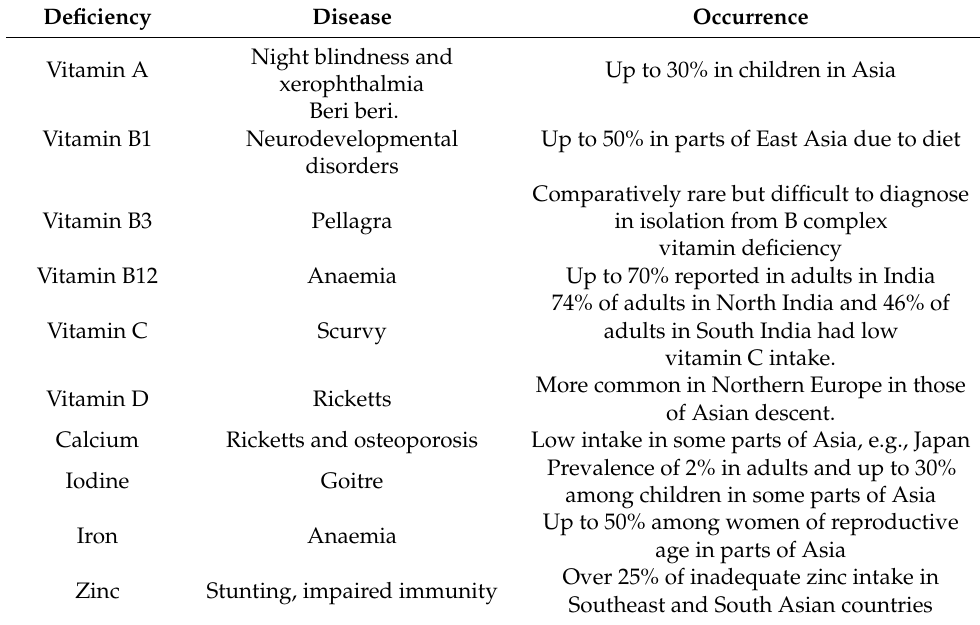
Table 2. Micronutrient deficiencies and their occurrence in